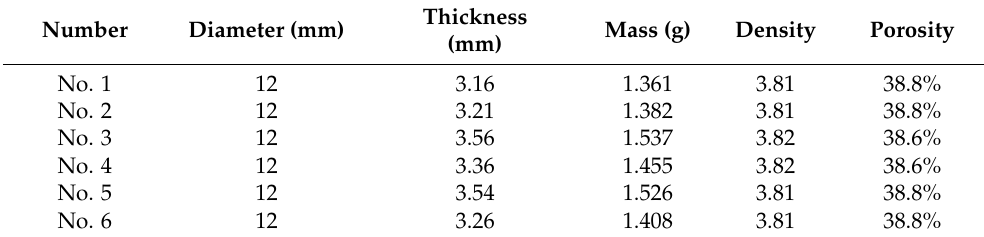
Table 1. Parameters of Nb and Al powder compact.